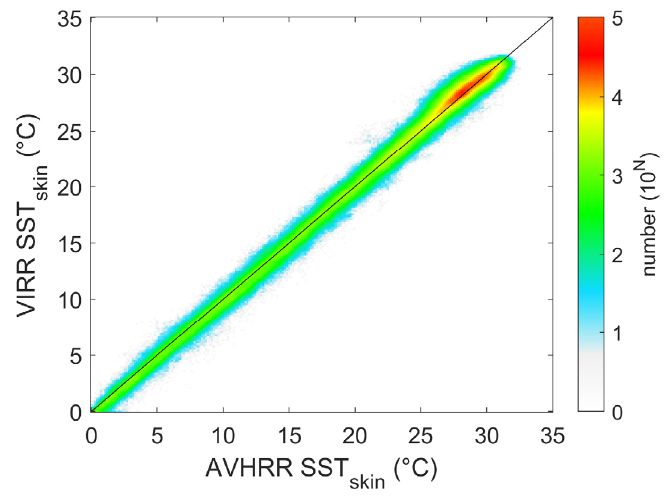
Figure 12. The relationship between the VIRR SST skin and the CCI AVHRR SST skin .